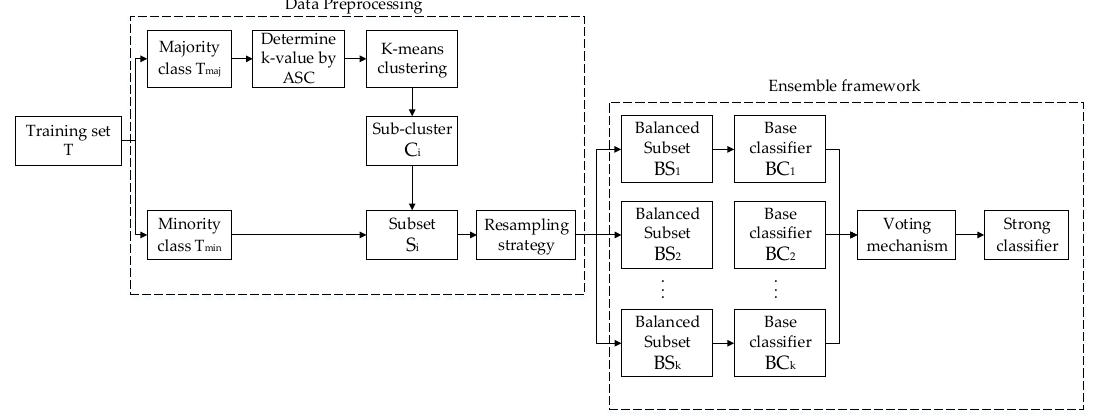
Figure 3. The procedure of EKR ( The ensemble framework based on K-means and resampling ) .